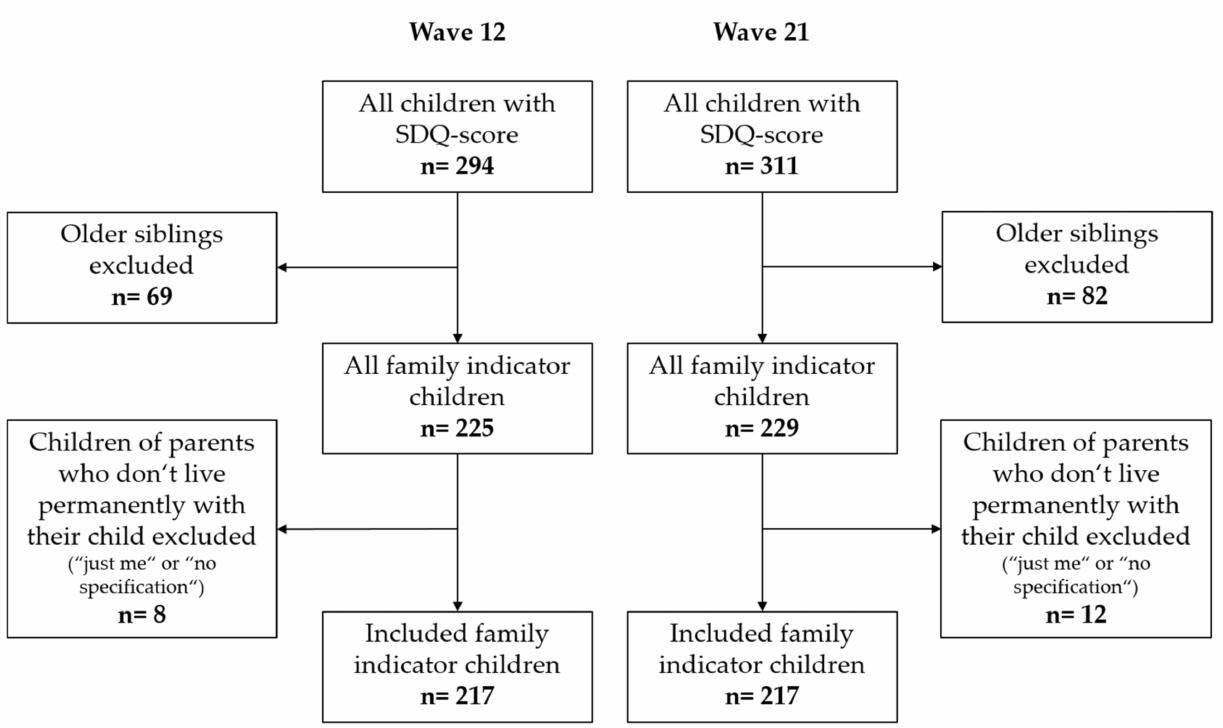
Figure A1. Flowchart to visualize the final study population of wave 12 and wave 21, as well as the exclusion